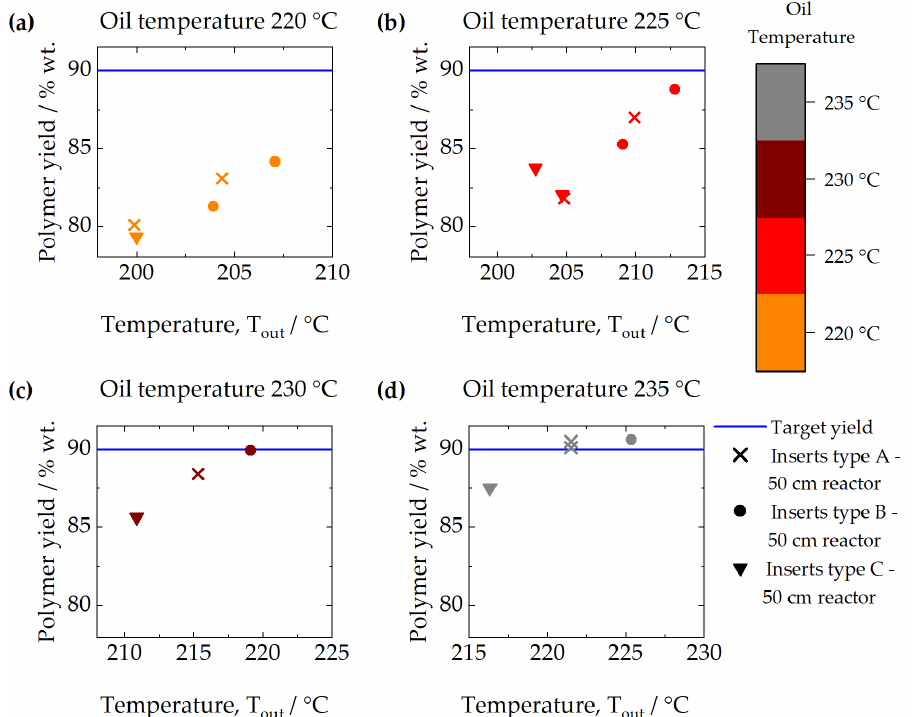
Figure 9. Comparison of the polymer yield versus the temperature at the reactor outlet using the different types of the internals, A, B, and C, in a 50 cm reactor for ( a ) set oil temperature of 220 °C, ( b ) set oil temperature of 225 °C, ( c ) set oil temperature of 230 °C, and ( d ) set oil temperature of 235 °C. The mass flow rate was set to 3.15 kg h − 1 ± 0.05 kg h − 1 and pressure was in the range of 2 ± 0.3 bar. The color scale represents oil set temperatures.